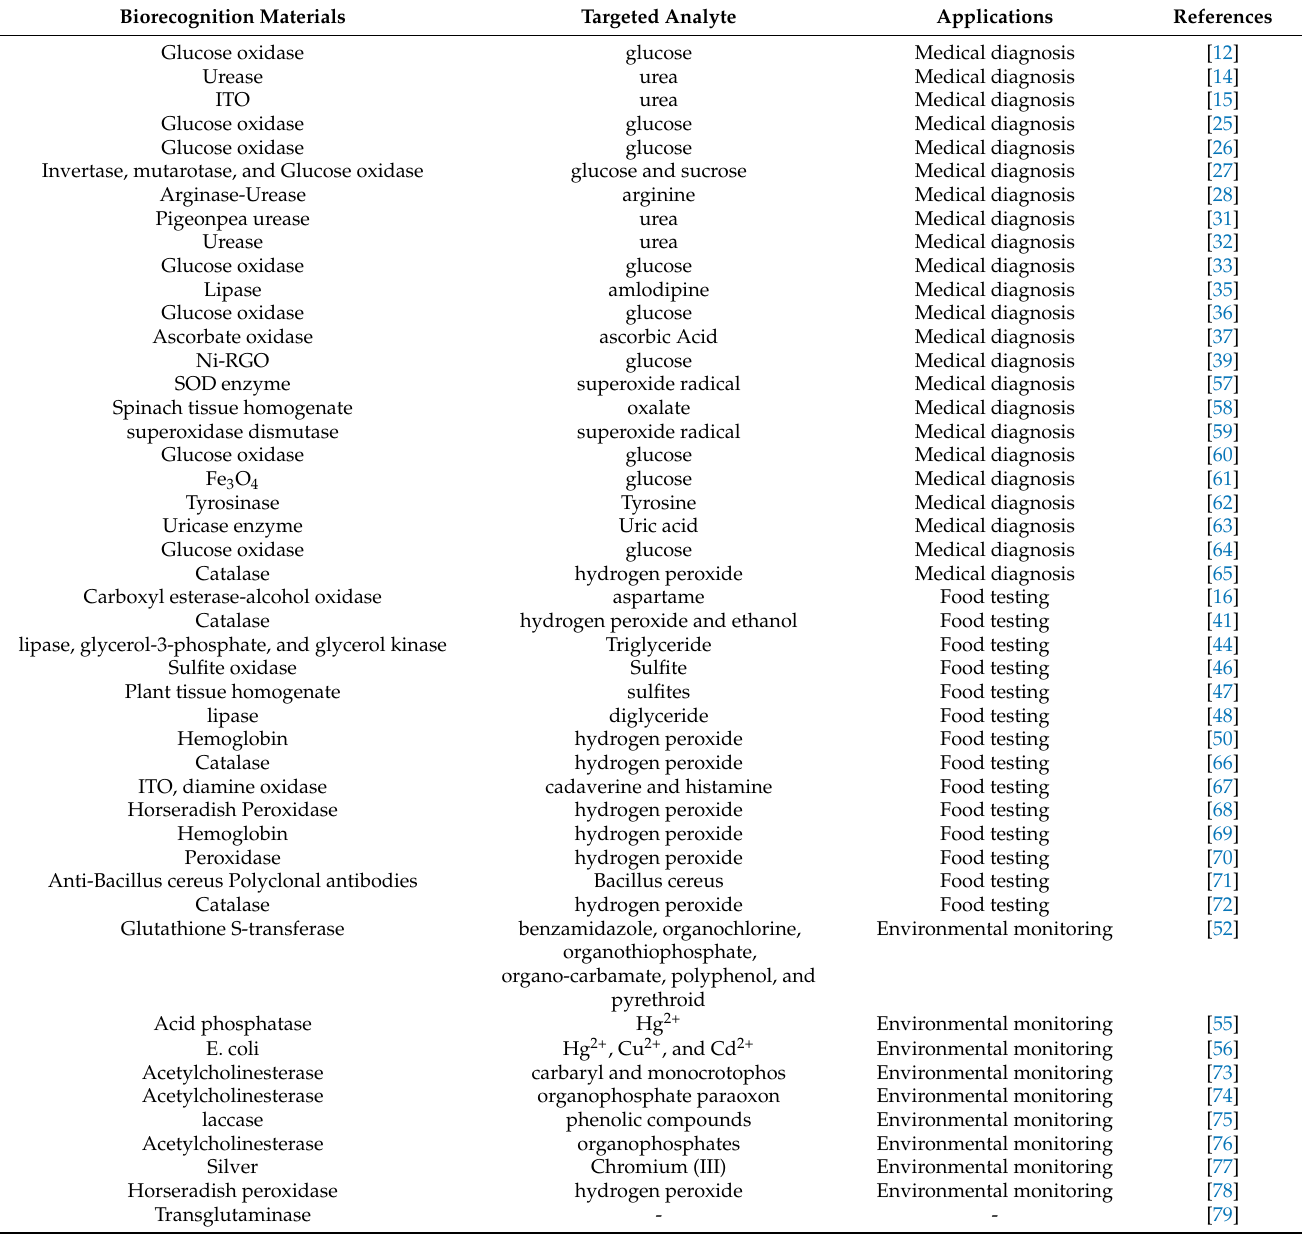
Table 1. Biosensors with gelatin as a matrix for immobilized biorecognition materials. Biorecognition